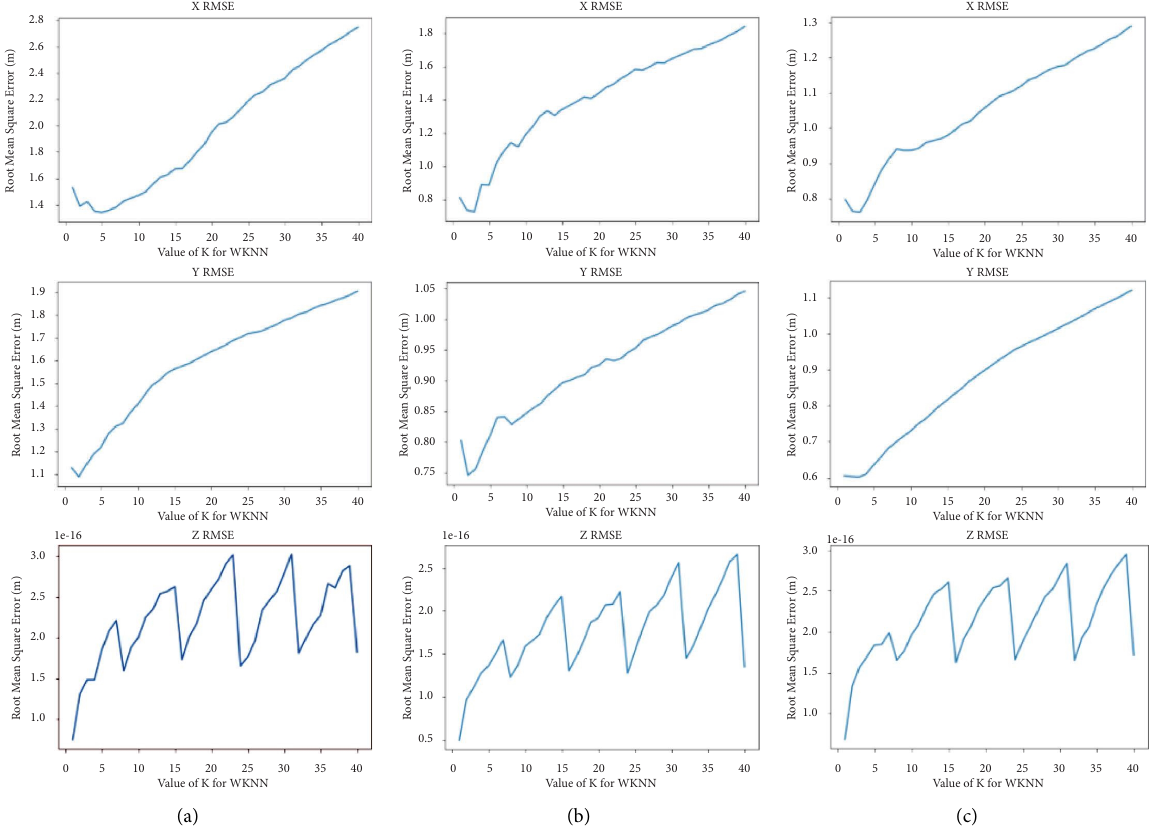
Figure 6: WKNN RMSE (a) 1 AP pair, (b) 2–10 AP pairs, and (c) 1–10 AP